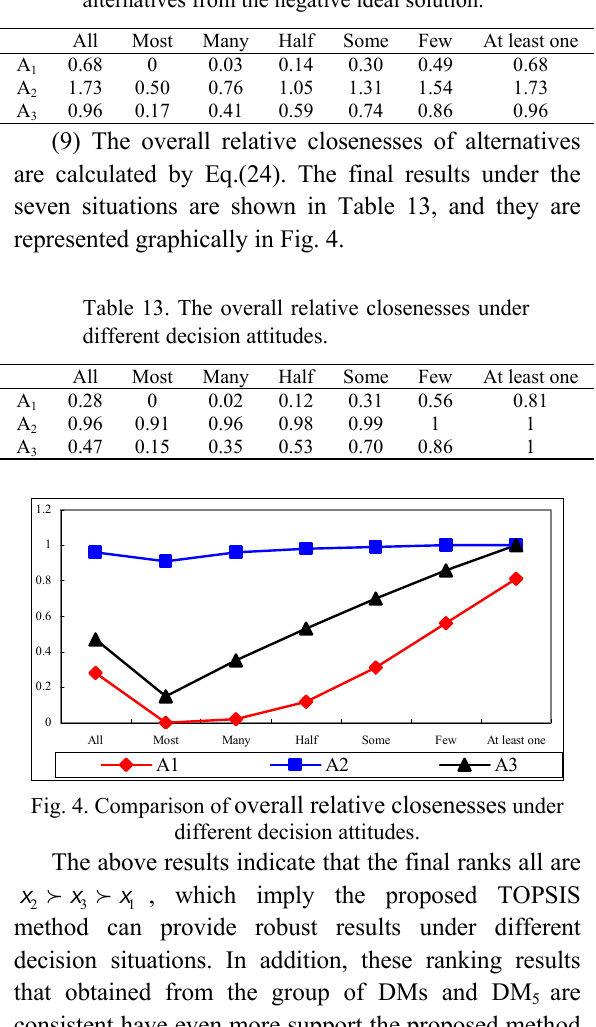
Table 12. The overall separation measures of alternatives from the negative ideal solution.